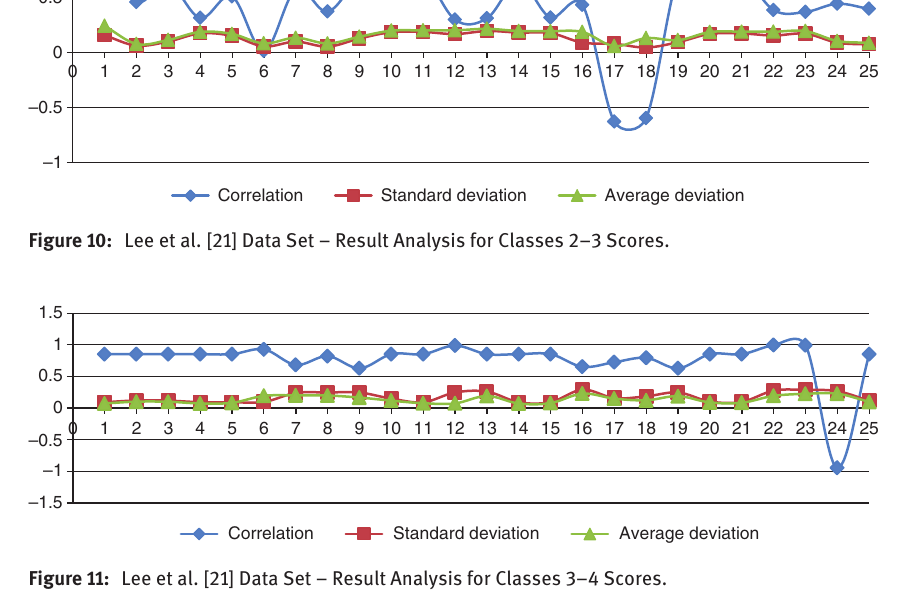
Figure 11: Lee et al. [21] Data Set – Result Analysis for Classes 3–4